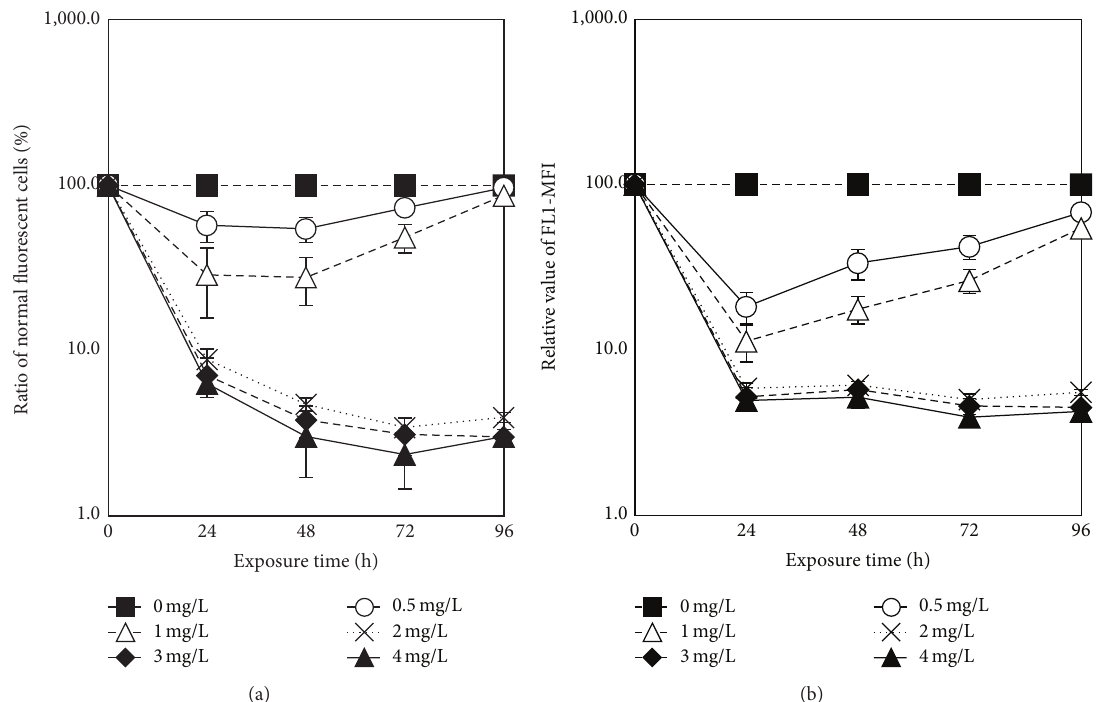
Figure 8: The effects of ethyl cinnamate on the esterase activities of C. vulgaris . ((a) The ratio of normal fluorescent cells and (b) the mean FL1 fluorescence.)